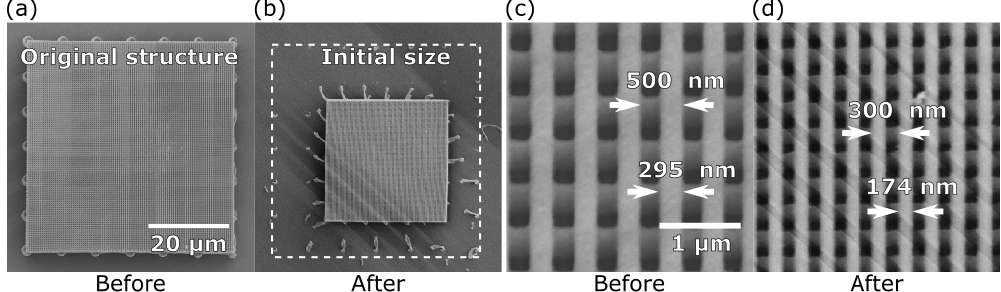
Figure 10. ( a ) SEM micrograph of a photonic crystal prior to ( a ) and after ( b ) pyrolysis; ( c ) the period and line width initially were 500 nm and 295 nm, respectively, which were shrunk to 300 nm and 174 nm after pyrolysis ( d ); a change of ∼ 40%. The period / width ratio stayed ∼ 1.7, indicating a homogeneous reduction in